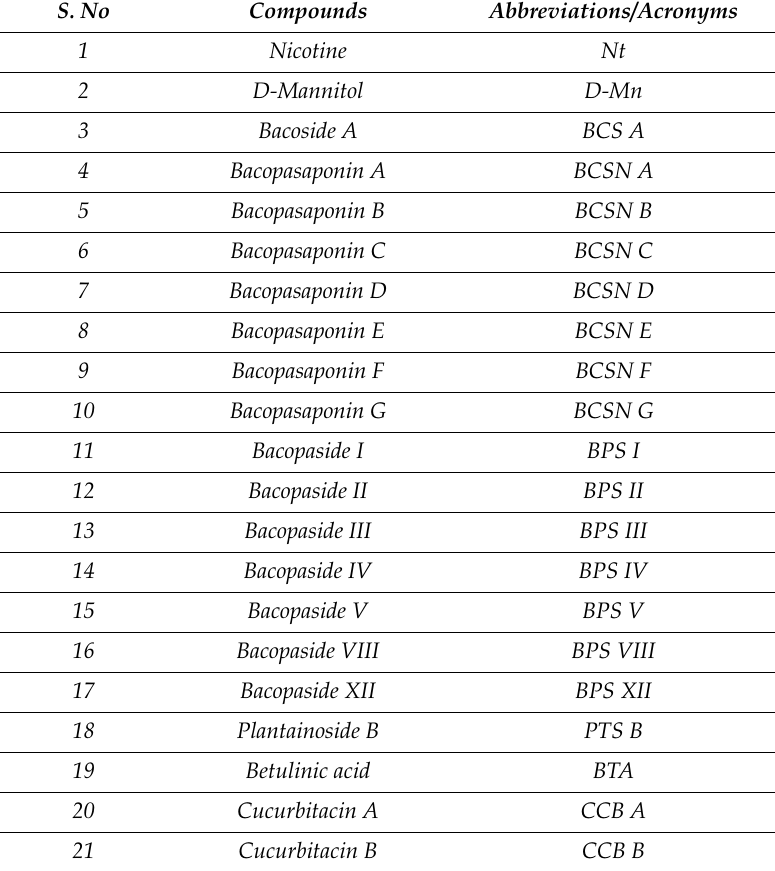
Table 1. List of